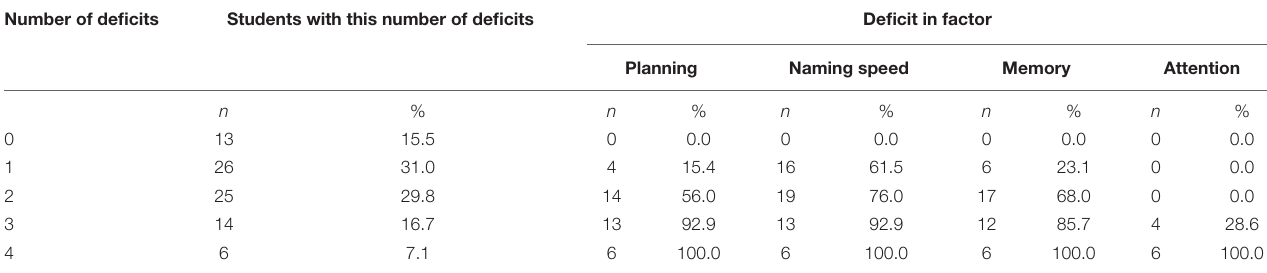
TABLE 5 | Overview of the distribution of deficits in primary factors. Number of deficits Students with this number of deficits Deficit in factor Planning Naming speed